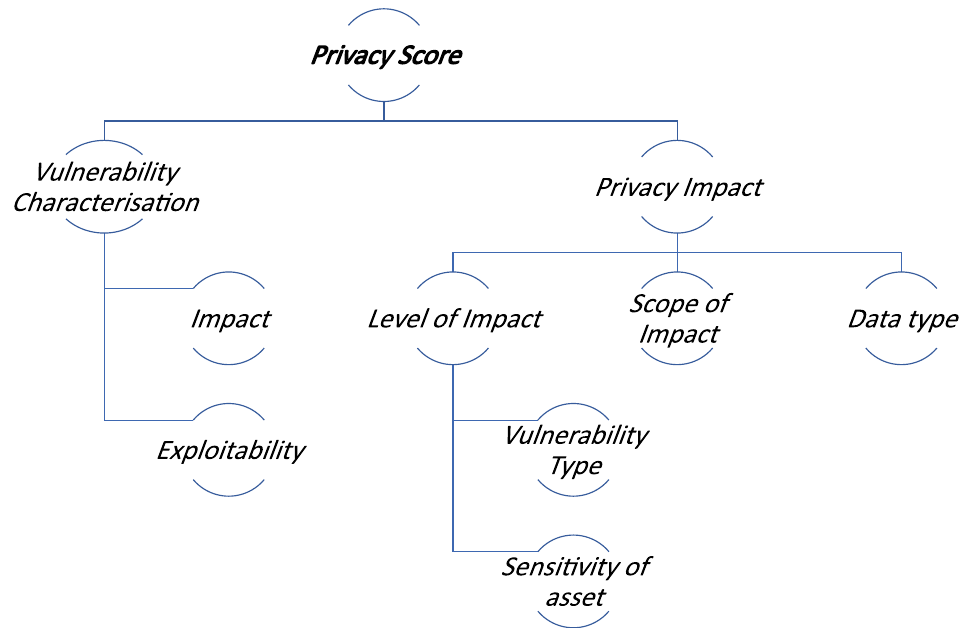
Figure 5. Structural view of Privacy score with the contributing